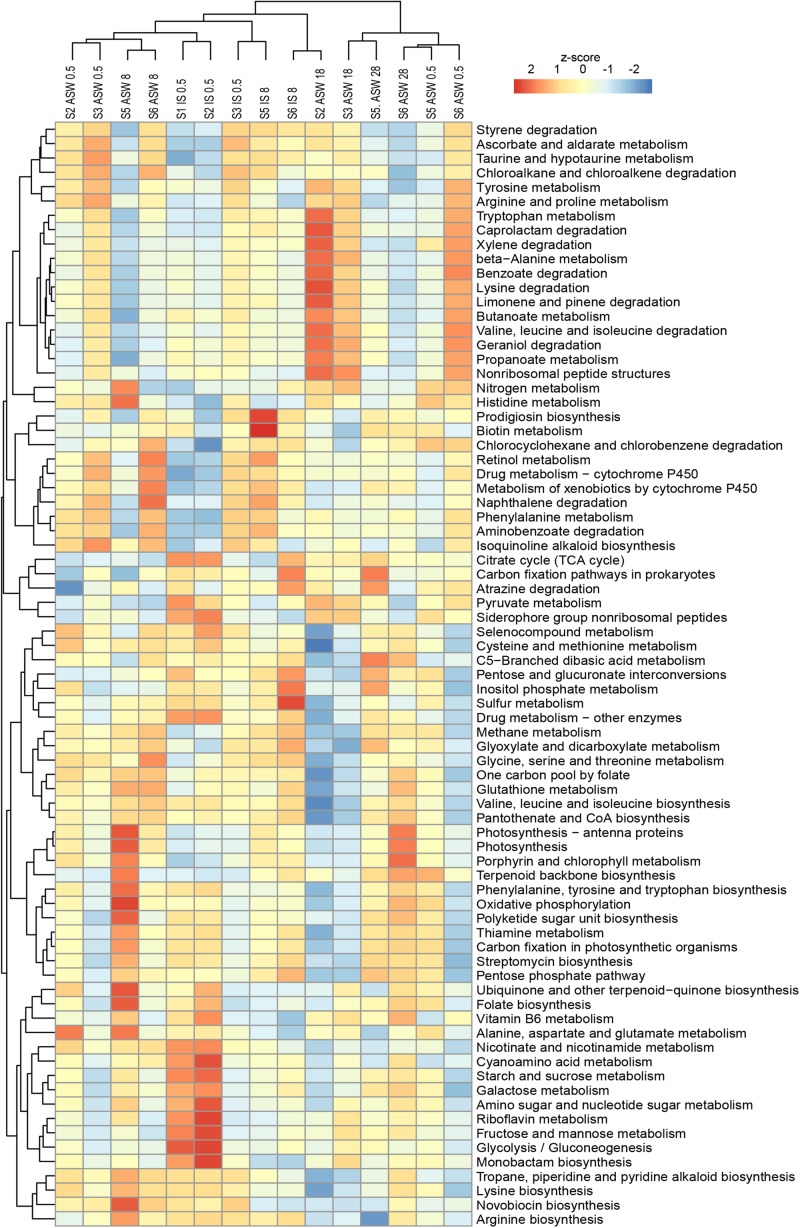
Variations of KEGG metabolic pathways in the functional microbial communities (with the threshold 5%). The heatmap shows the functional profiles based on the relative abundance of metabolic pathways after a z-score transformation. Freshwater samples: freshwater in situ salinity (IS-0.5), artificial seawater control (ASW-0.5) where salinity was adjusted to freshwater salinity, artificial seawater raised to 18 for freshwater snails hyperosmotic treatment (ASW-18). Brackish water samples: brackish water in situ salinity (IS-8), artificial seawater control where salinity was adjusted to salinity 8 (ASW-8), artificial seawater raised to salinity 28 for brackish water snails hyperosmotic treatment (ASW-28), artificial seawater with salinity 0.5 for brackish water snails hypoosmotic treatment (ASW-0.5). Samples are clustered based on similarity.